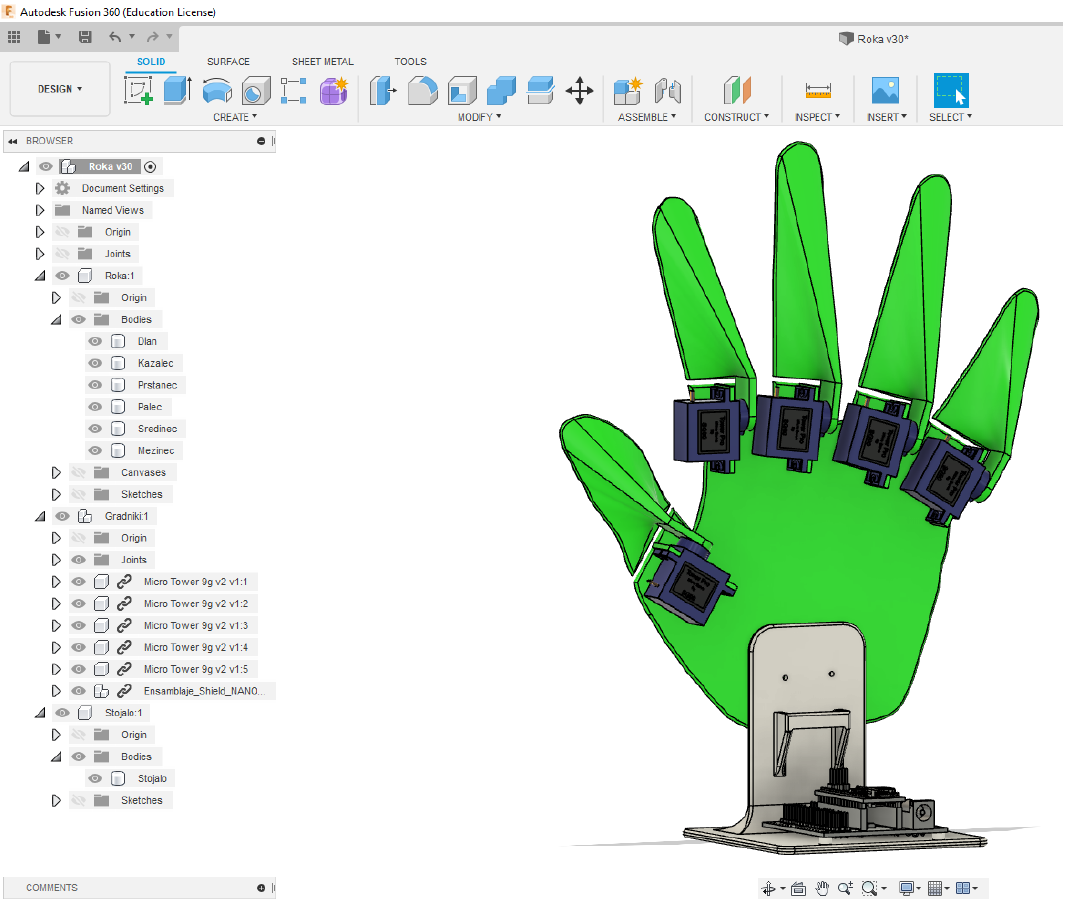
Figure 11. Rehabilitation hand design in